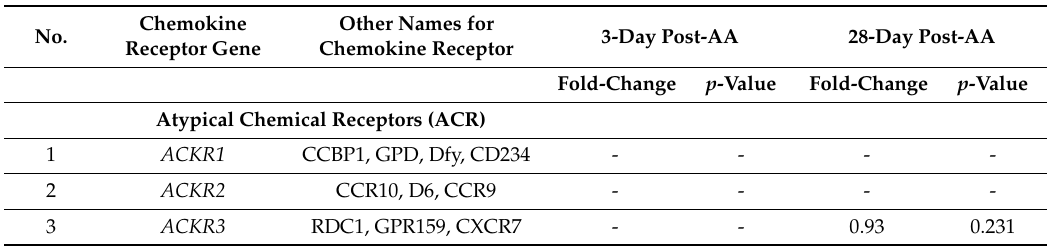
Table 2. Individual distal colonic gene expression of 24 described chemokine receptor genes three days post-AA and 28 Days